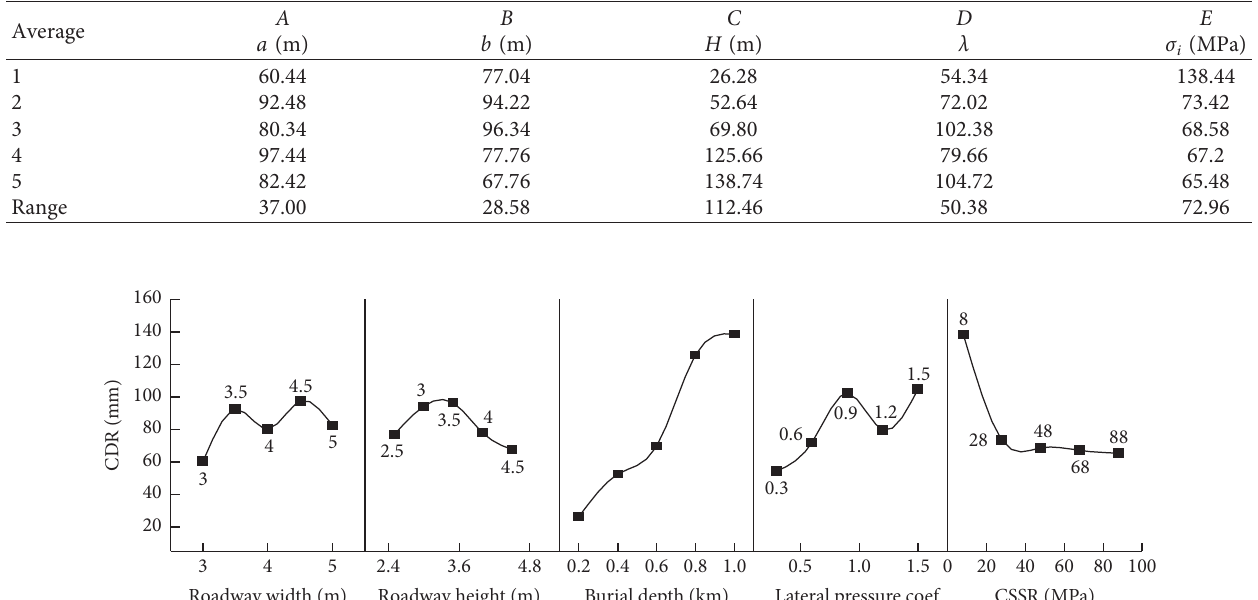
Table 4: Extremum difference analysis of comprehensive deformation of